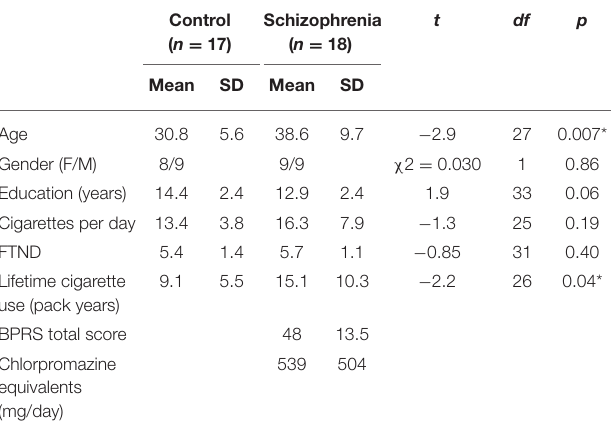
TABLE 1 | Cohort 1: Demographics and clinical data.